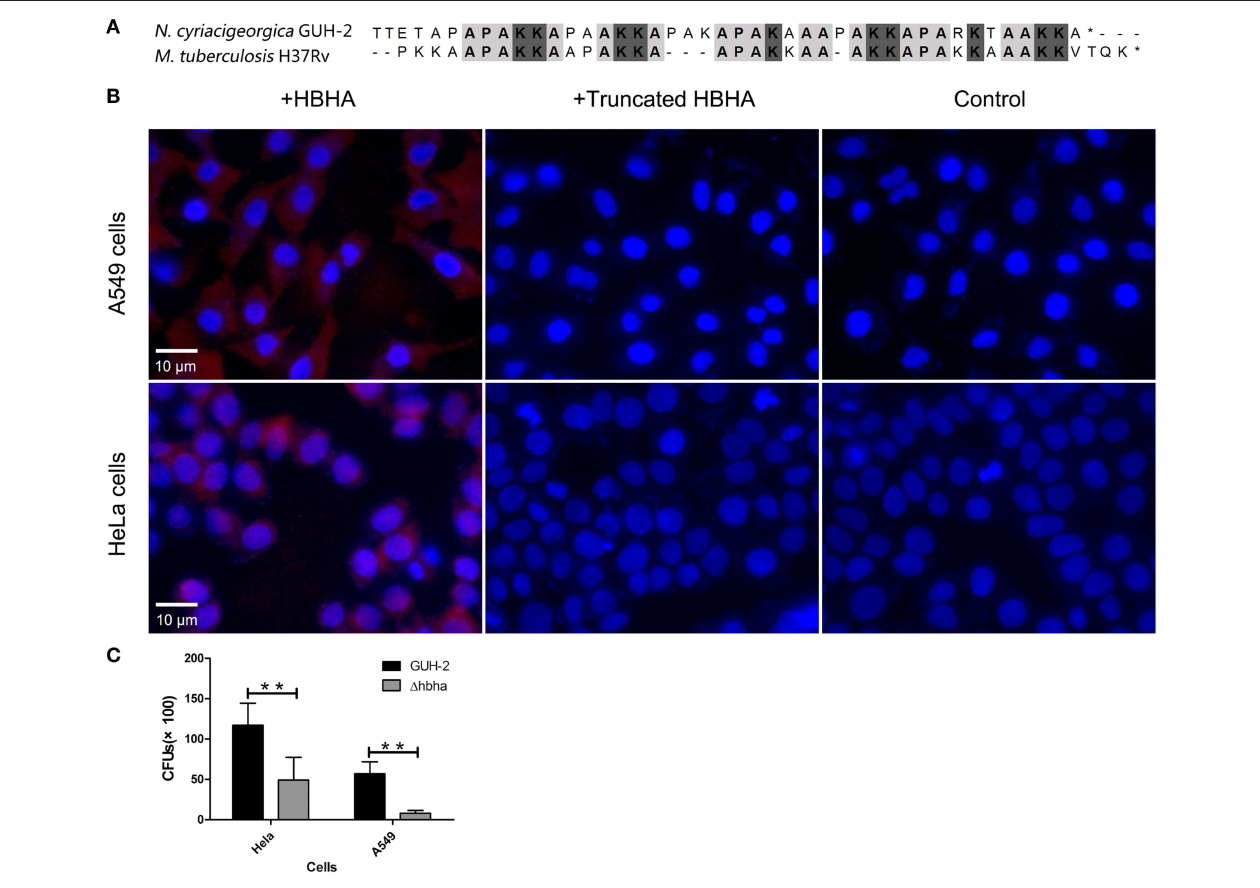
FIGURE 3 | N. cyriacigeorgica HBHA adheres to A549 cells and HeLa cells. (A) Amino acid sequence alignment between N. cyriacigeorgica HBHA and Mycobacterium tuberculosis HBHA. (B) Immunofluorescent assays demonstrate the adhesion of N. cyriacigeorgica HBHA to A549 cells and HeLa cells. HBHA protein or the HBHA protein lacking C-terminal domain (10 µ g) was added to A549 cells or HeLa cells separately for 1h, and the protein adhesion onto the cells was detected with fluorescent microscopy. Data are representative of at least three independent experiments. (C) HeLa or A549 cells were infected with wild-type or 1 hbha strains for 1h, and the bacteria adherence to cells was then determined. The assays were performed in triplicate, and the results are expressed as the means ± SD. ** P < 0.01. in rapid phosphorylation of p38, ERK1/2, and p65 at 15 min after stimulation, as well as phosphorylation of JNK at 30